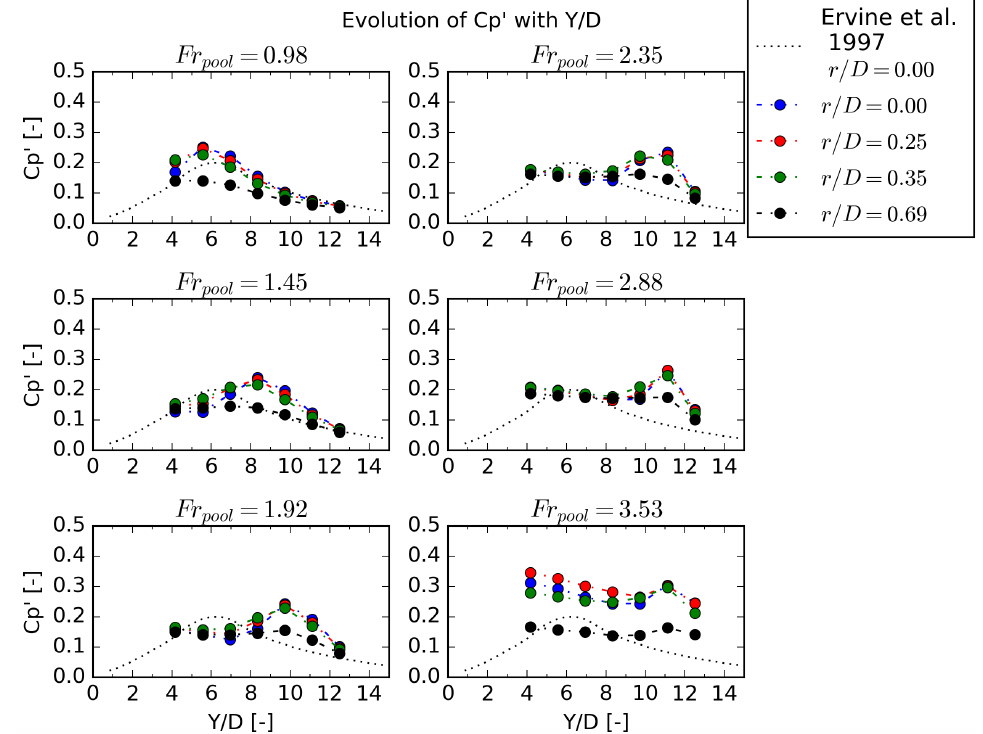
Figure 8. Fluctuating dynamic coefficient Cp (cid:48) [-] as a function of the pool depth ratio Y / D —at a radial distance r / D = 0.00–0.25–0.35–0.69—Jet break-up length ratio H / L b ≤